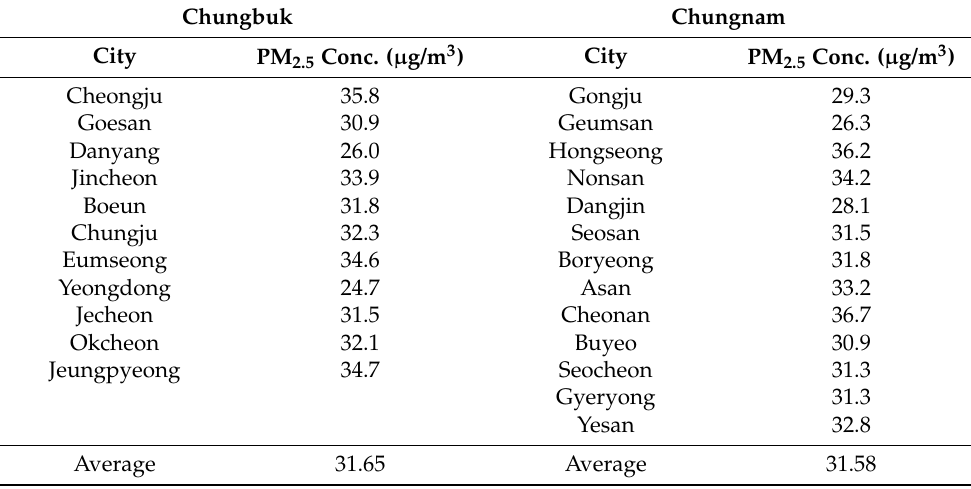
Figure 9. Monthly mean PM 2.5 concentration in Chungcheong under Base scenario. Table 9. Predicted average PM 2.5 concentration under Base scenario in Chungcheong in March 2017 .